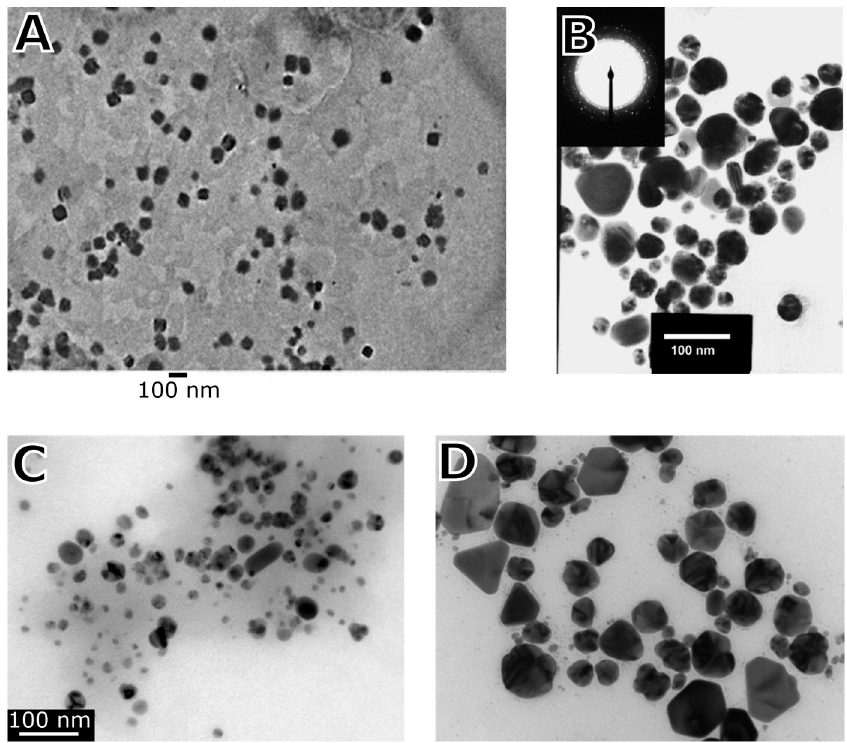
Figure 1. Shapes of metal-containing NPs created by mycosynthesis. ( A ) Cubic shaped Fe 3 O 4 NPs created with filamentous fungus, Aspergillus japonicus. Reprinted from [34]. Copyright by Springer Nature. Reprinted with permission. ( B ) Ag NPs with the shape of hexagonal pyramids created with white rot fungus, Phaenerochaete chrysosporium. Reprinted from [37]. Copyright by Elsevier. Reprinted with permission. ( C ) Ag NP with spherical and rod shape created with filamentous fungus, Trichoderma viridae . Reprinted from [39]. Copyright by Elsevier. Reprinted with permission. ( D ) Ag NPs with circular, triangular, and hexagonal shapes synthesized with entomopathogenic fungus, Beauveria bassiana . Reprinted from [40]. Copyright by Springer Nature. Reprinted with permission.